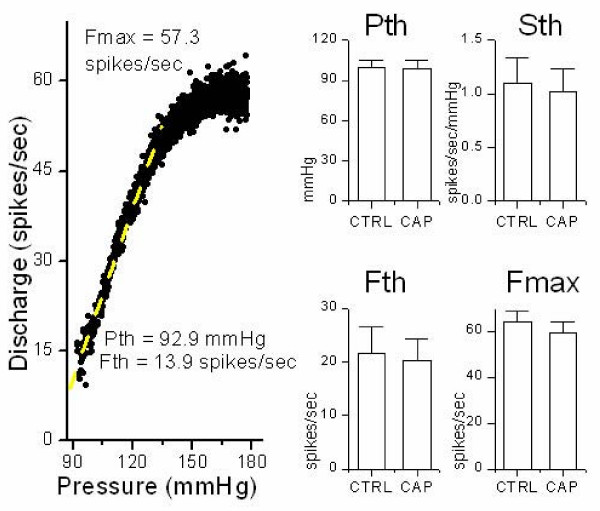
Capsaicin-resistant baroreceptors. Capsaicin effects on the pressure-discharge relations of regularly discharging, single-fiber, aortic BRs were assessed by comparing four key discharge parameters. Pressure threshold (Pth) and threshold frequency (Fth) were calculated as the average pressure and frequency (respectively) for the first 10 discharge points. The slope sensitivity (Sth) was based on a least squares, linear regression fit of the discharge points over the initial 20–40 mmHg of the relation (white dashed line). The maximum discharge (Fmax) averaged the discharge frequency sampled from the highest 20 mmHg for that unit – generally >200 points. The classification as regularly discharging was based on a moderate (<%) coefficient of variation (COV) of discharge, high Fmax (>50 Hz) and high slope-sensitivity (>0.5 spikes/sec/mmHg) – all characteristic of A-fiber BRs. 1 μM CAP for 15 min failed to alter the pressure-discharge response of regularly discharging BRs (n = 10) or their mean discharge parameters. The COV was calculated using this same sample and for this BR was 2.94%. Linear regression fit (Y = A + B * X) yielded A=-75.0 ± 0.9, B = 0.95 ± 0.01, R = 0.99 ± 1.68, n = 470 points, p-value<0.0001. Averages (± SEM) of these derived parameters for Pth, Sth, Fth and Fmax.